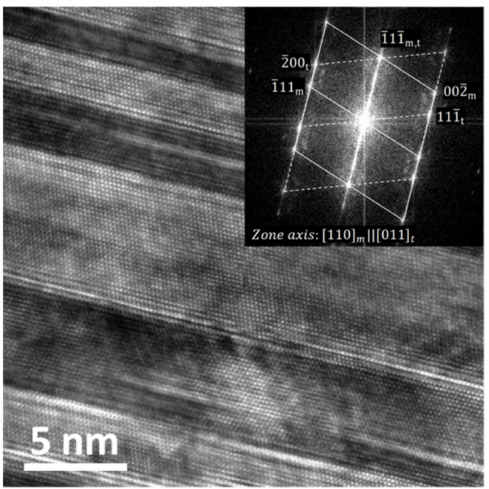
Figure 4. The HRTEM image of the film with 0.6 at.% Nb with the corresponding FFT image in the inset. (m: matrix, t: